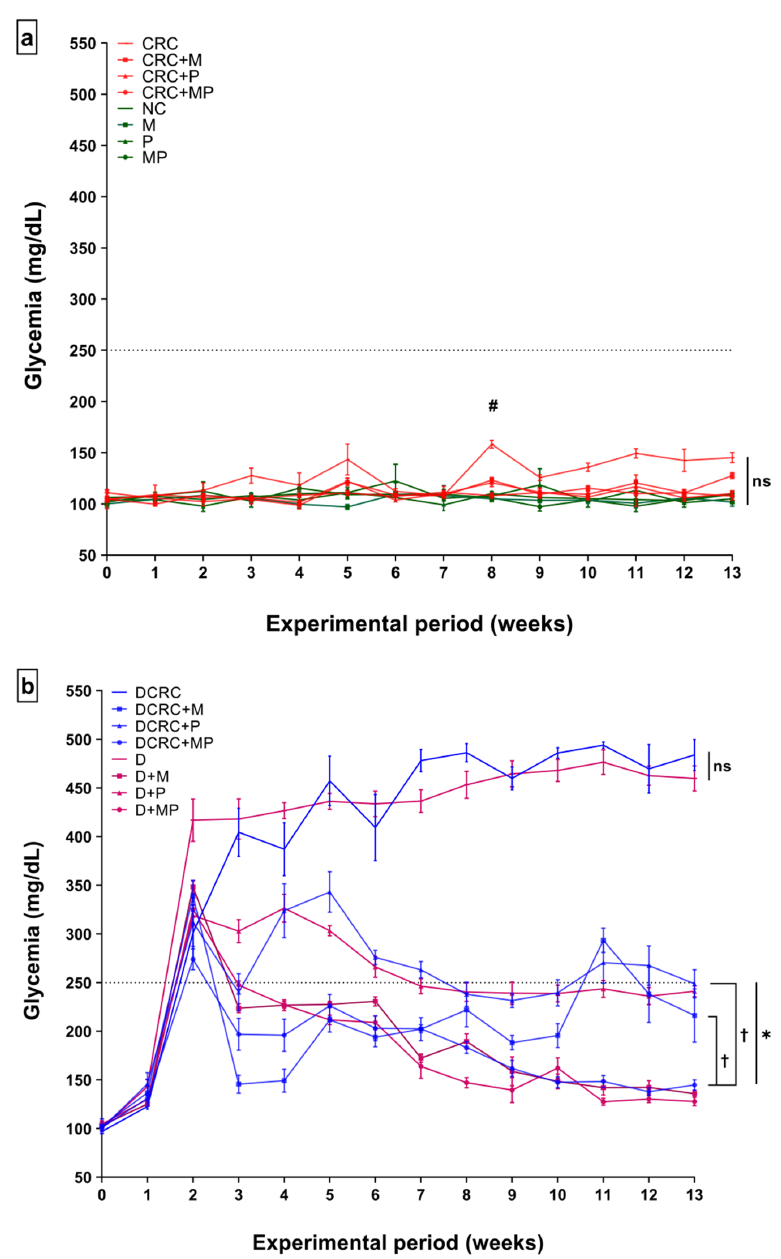
Figure 1. E ff ects of probiotics and metformin on glycemia levels in nondiabetic ( a ) and diabetic ( b ) Mice. Statistical significance was expressed by # p < 0.05 in nondiabetics when compared to their experimental colorectal cancer control (CRC group) and * p < 0.05 in diabetics when compared to their experimental control, the diabetic colorectal cancer mice (DCRC group) with n = 6 animals per group. Moreover, when comparing only two groups, connecting lines were used to indicate the compared groups with † p < 0.05, (ns) indicates nonsignificant.